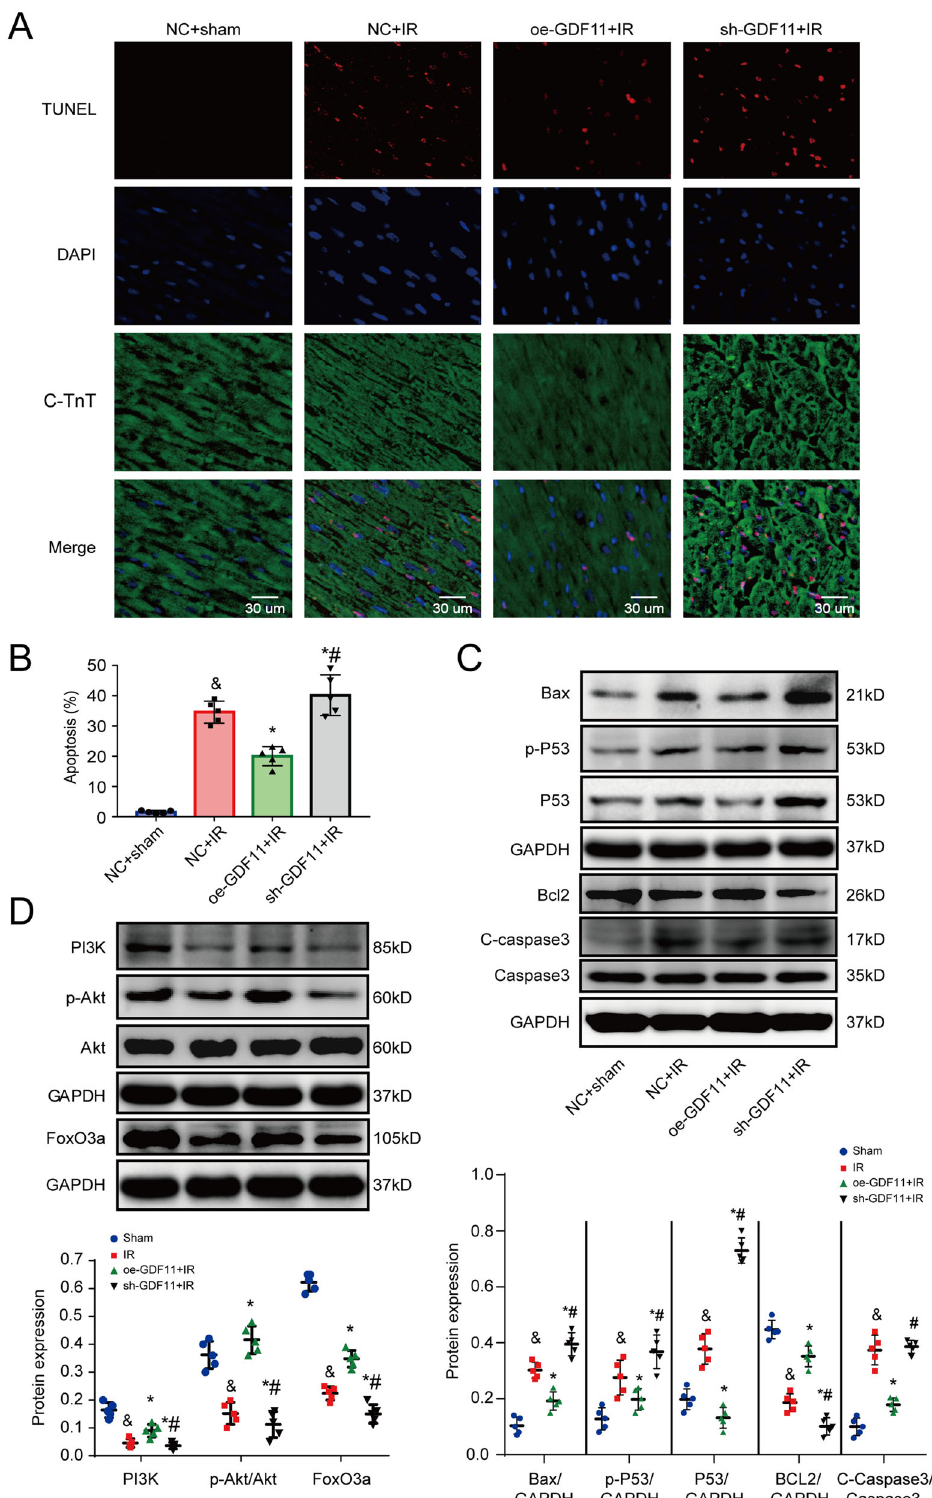
Fig. 5 Effects of overexpressing or silencing GDF11 on IR-induced myocyte apoptosis in mice. A Representative photographs of TUNEL- stained cells. B Quantitative analysis of TUNEL-positive cells. C Representative images and semiquantitative analysis of western blots for Bax, P53, p-P53, C-caspase3, Caspase3, and Bcl2. D Representative images and semiquantitative analysis of western blots for PI3K, Akt, FoxO3a, and p-Akt. & p < 0.05 vs. the sham group; * p < 0.05 vs. the IR group; # p < 0.05 vs. the oe-GDF11 + IR group; n = 5, one-way ANOVA followed by Bonferroni ’ s correction for post-hoc multiple comparisons in panel ( B , D , F ). GDF11 growth differentiation factor 11, IR ischemia/reperfusion, oe-GDF11 GDF11 overexpression, sh-GDF11 short hairpin of GDF11.